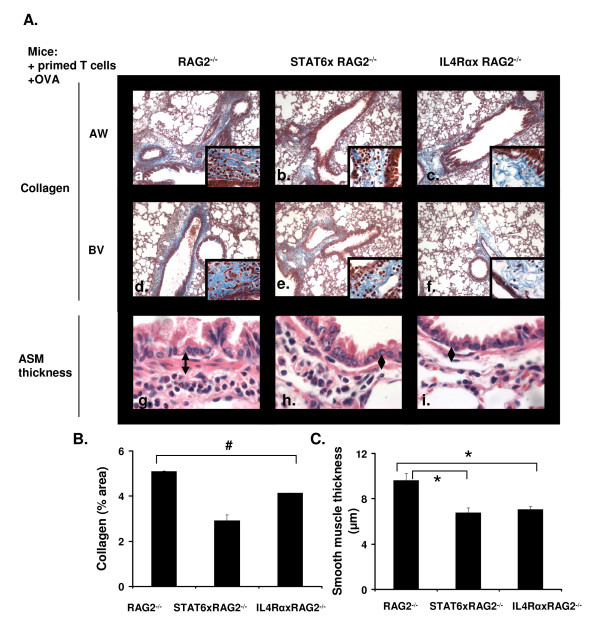
Reduced airway remodeling in mice deficient in STAT6 and IL-4Rα. RAG2-/-, STAT6xRAG2-/- or IL-4RαxRAG2-/- mice were subjected to the asthma protocol described in Figure 3. (A) Paraffin embedded lung sections from each group of mice were stained with Masson's Trichrome. Keratin and muscle fibers are stained in red, collagen in blue, cytoplasm in light red/pink and nuclei in black. Photomicrographs of collagen deposition around the airways (panels a-c) or blood vessels (panels d-f) were collected at 10× (panels a-f) and 100× (inset) magnification. Photomicrographs (100×) of the airway smooth muscle (ASM) layer in H&E stained lung sections from each mouse group is shown in panels g-i. Arrows depict the thickness of the ASM layer (transverse section). (B) The amount of collagen present in the lung was quantified using NIH Image J software. Data is represented as area of collagen (blue stain) ± SEM. # p < 0.001. n = 20 airways/blood vessels per group. (C) The distance between the innermost aspect and outermost aspect of the smooth muscle was measured at 3 different positions around each airway, using NIH Image J software. Data is represented as airway smooth muscle thickness in μm ± SEM. * p < 0.01. An average of 30 airways was used for each group.